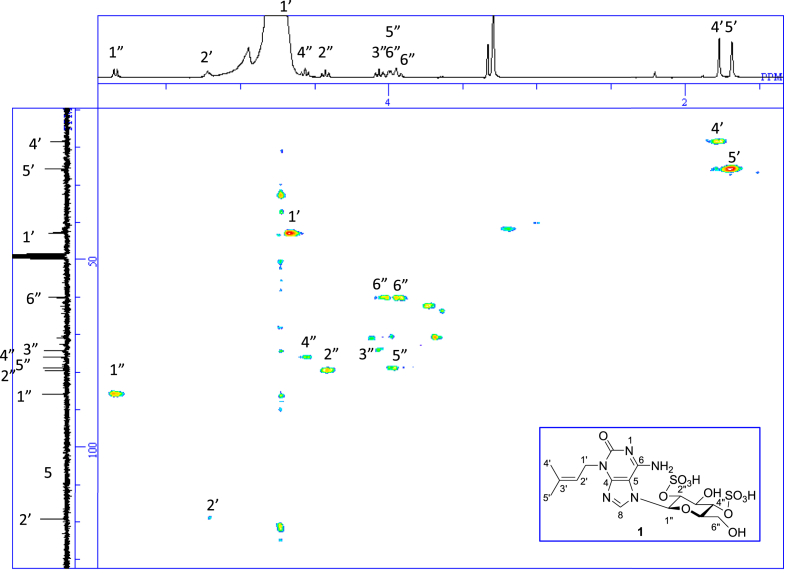
1H–13C HSQC of 1.